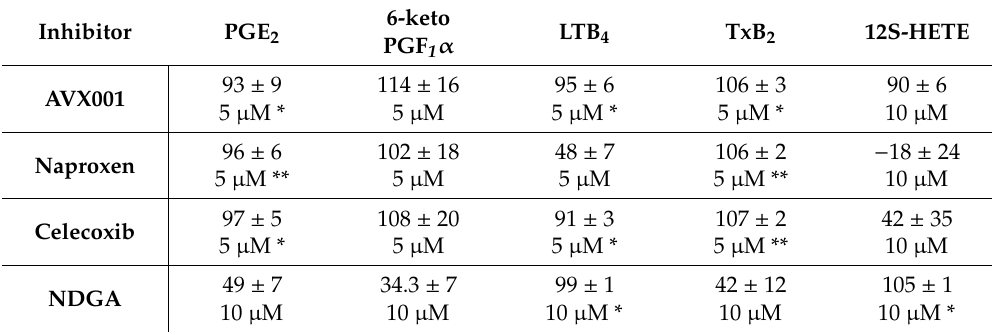
Table 1. Inhibition of eicosanoid release in A23178-stimulated peripheral blood mononuclear cells (PBMC). Eicosanoid levels were measured in the supernatants of PBMC pre-incubated with AVX001, naproxen, celecoxib, or nordihydroguaiaretic acid (NDGA) in the range of 0.5-10 µ M and stimulated with A23178 (30 µ M, 15 min). The percentage inhibition of the A23178-stimulated release was calculated for each eicosanoid and is shown as the mean ± standard error of the mean (SEM) for n = 4 (prostaglandin E 2 (PGE 2 )), n = 4 (leukotriene B 4 (LTB 4 )), and n = 3 (12S-hydroxyeicosatetranoic acid (HETE)) individuals. The inhibitor concentration at which maximal inhibition was reached is given below. Statistical significance was calculated using Kruskal–Wallis tests with Dunn’s